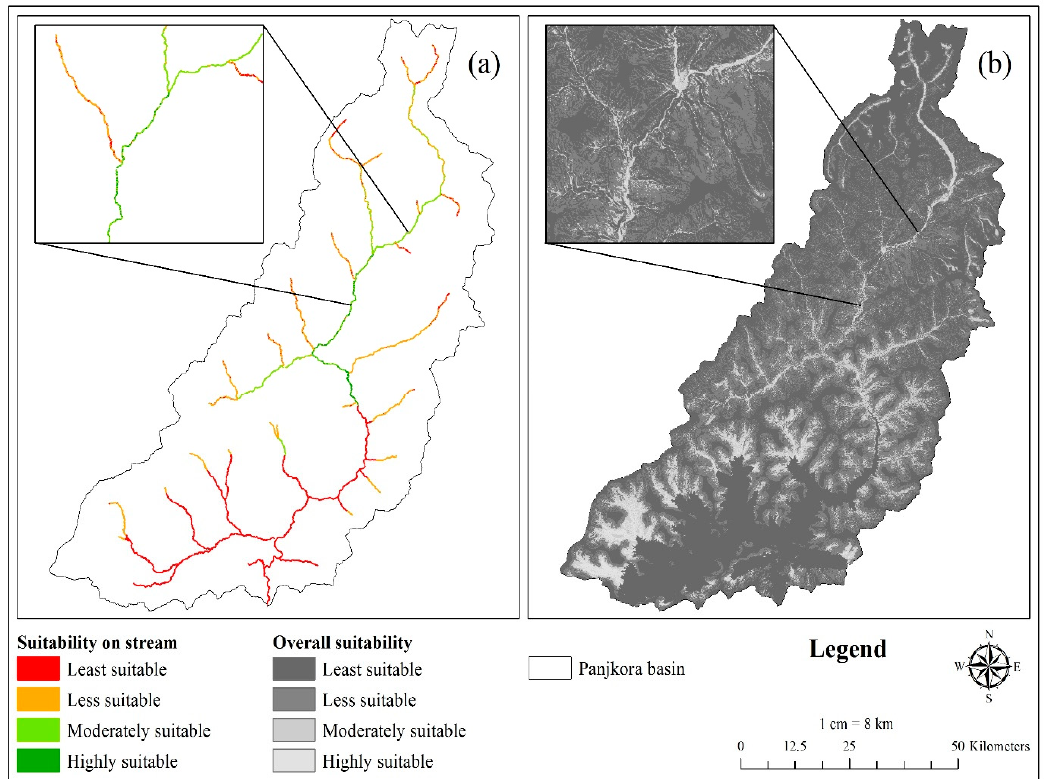
Figure 10. Suitability maps: ( a ) suitability on stream ( b ) overall suitability.